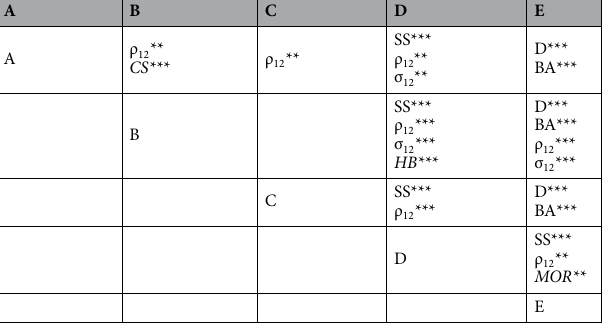
Table 3. ANOVA of five different chestnut stands on the Amiata mountain, related to dendrometric parameters and physical wood properties. Wood density at 12% moisture (ρ12), total shrinkage (βV), compression strength (σ12), bending strength (MOR), Brinell hardness (HB) and ring width (RW). D diameter at breast heigth, BA individual basal area, SS shoot per stools. *** p < 0,001 ** p < 0,01 * p <